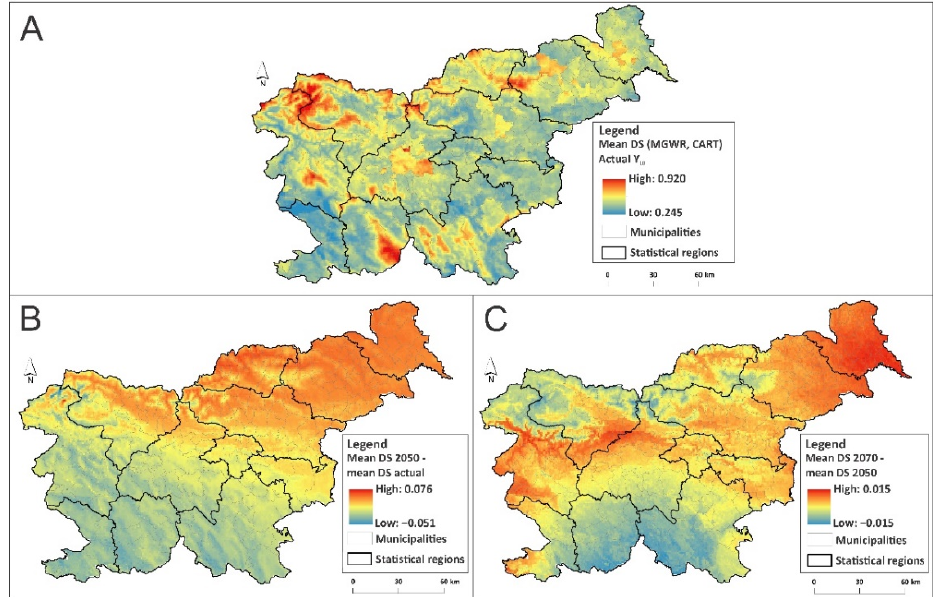
Figure 6. ( A ) Current LB infection risk map (MGWR and CART ensemble mean value); ( B ) infection risk difference under the RCP8.5 scenario between 2050 and the current state; ( C ) infection risk difference under the RCP8.5 scenario between 2070 and 2050. All future predictions are based on the mean values derived from five different global climate models (HadGEM2-ES, CCSM4, MIROC-ESM, HadGEM2-CC and MPI-ESM-LR).